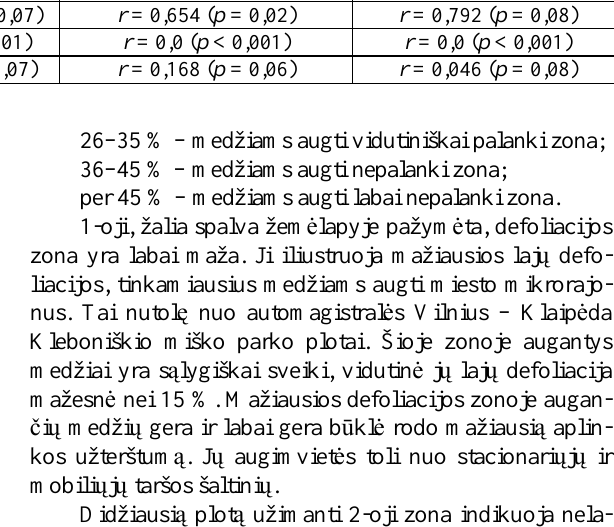
Table 4. Correlation between sampled tree morphological parameters and the concentration of pollutants Vidutinis der ė jimo Vidutinis saus ų šak ų Teršalai Vidutin ė lajos defoliacija (%) laipsnis (balais) kiekis (%) Azoto dioksidas r = 0,702 ( p = 0,04)